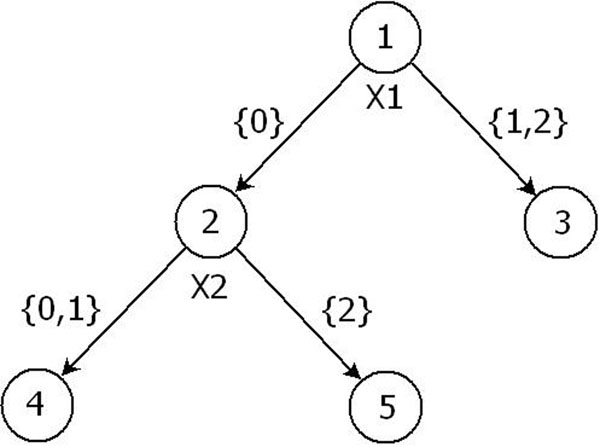
Example tree. An example tree fitted using phenotype Y and a group of SNP variables X1, X2, X3, and X4. X1 and X2 are used as the partitioning variables, yielding three leaf nodes. X1, X2, X3, and X4 are the searched SNPs, and X1 and X2 are the final SNPs used in the tree. The branches of this tree are grouped into two categories depending on the prediction value (case or control) of each leaf node. A bilevel marker is then constructed according to this categorization of branches.